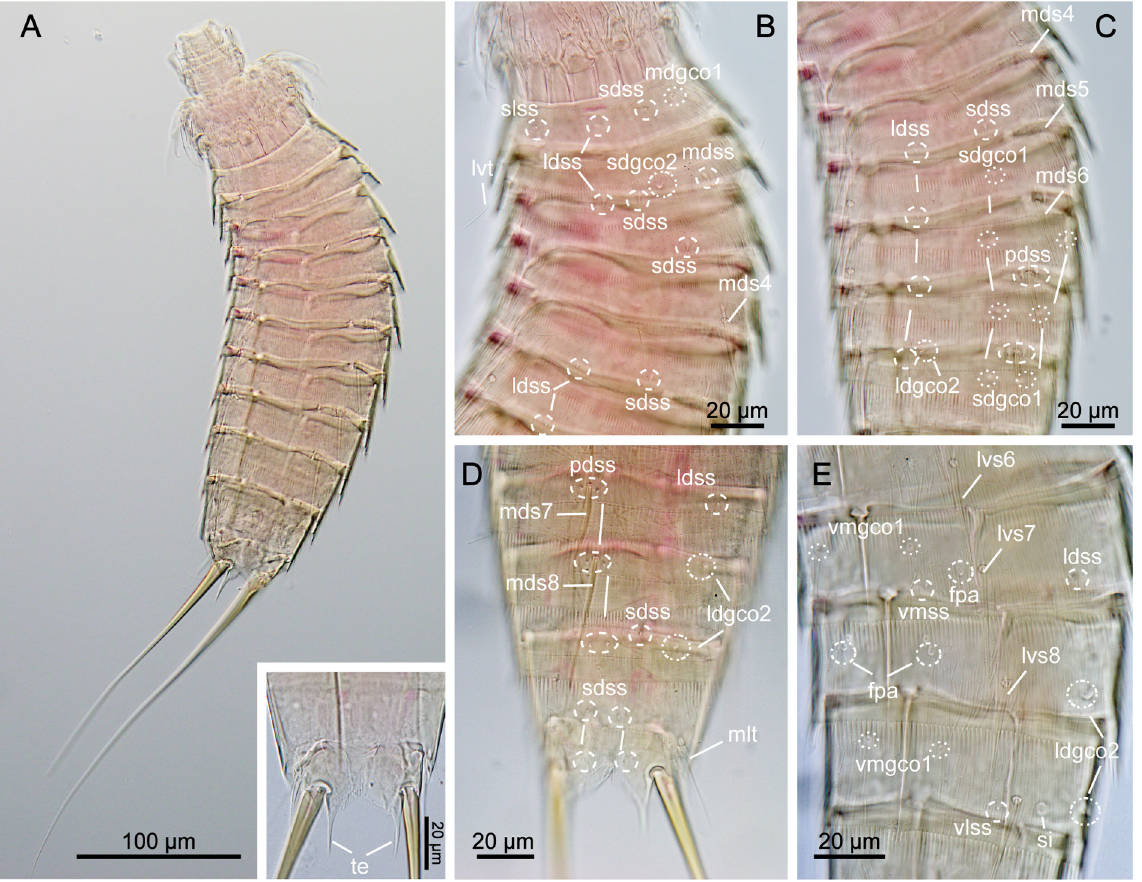
Fig. 34. Light micrographs showing overview and details of Echinoderes sp. aff. E. lupherorum . A–C . ♂ (NHMD-921636). D . ♂ (NHMD-921635). E . ♀ (NHMD-921632). A . Lateroventral overview, with inset showing close-up of segment 11. B . Segments 1 to 6, dorsolateral view. C . Segments 4 to 9, dorsolateral view. D . Segments 8 to 11, dorsal view. E . Segments 6 to 9, lateroventral view. Abbreviations: see Material